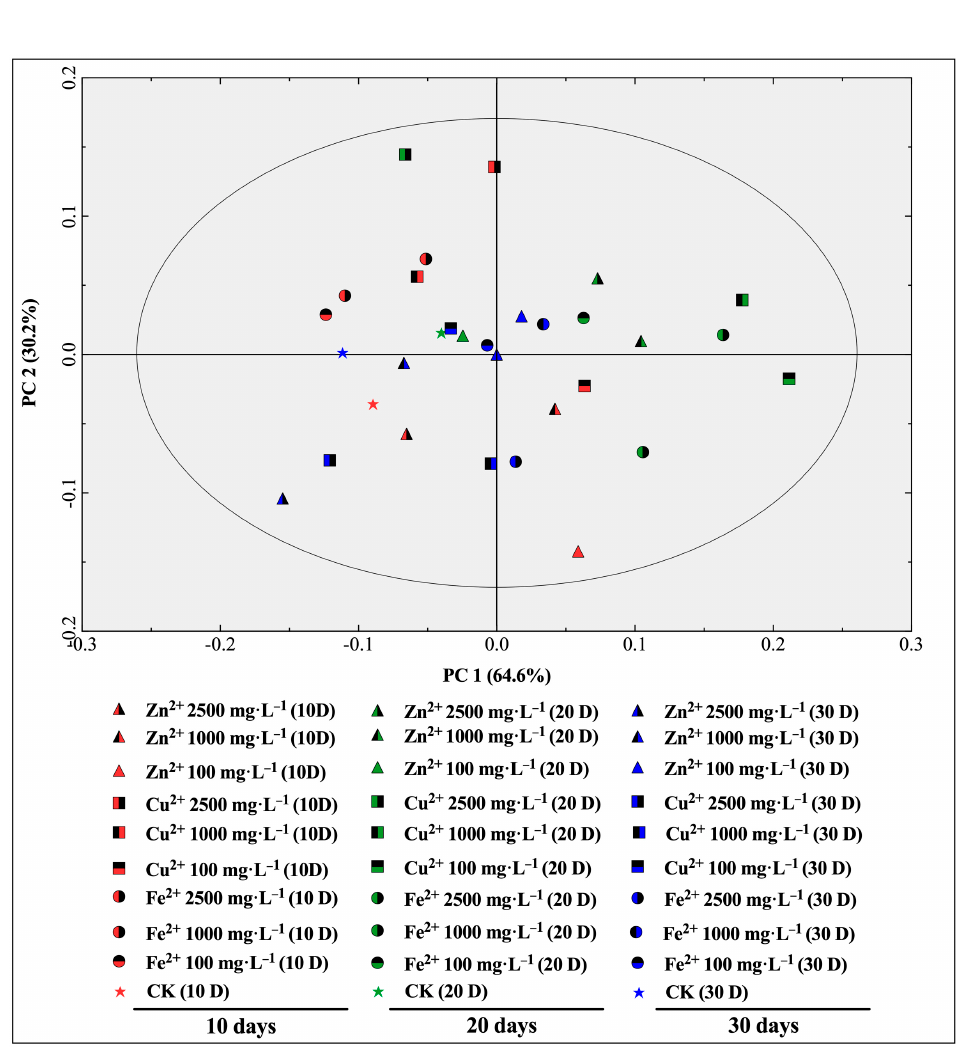
Figure 5. Coefficients plot ( A ) and VIP plot ( B ) of the characteristic absorption peaks in E. sagittatum leaves subjected to FT-IR under the OPLS-DA model. 3.4. Widely Untargeted Metabolomic Analysis of E. sagittatum Leaves According to the HPLC analysis in this study, high-concentration Fe 2+ (2500 mg·L − 1 ) had a more positive effect on flavonoids in E. sagittatum leaves. Therefore, the widely un- targeted metabolomic analysis carried out by UPLC-MS/MS aimed at deciphering the ef- fects of Fe 2+ on the metabolites in E. sagittatum leaves. Basic metabolite information of Fe 2+ (2500 mg·L − 1 ) and CK ( n = 6) based on widely untargeted metabolomics is shown in Figure 6. The average retention time and m/z of positive and negative ions are shown in Figure 6A. The m/z of the positive ions is concentrated between 200 and 650. The m/z of the neg- ative ions is concentrated between 400 and 800. We have demonstrated the overall differ- ences in metabolites between Fe 2+ and CK using the partial least squares discriminant analysis (PLS-DA) (Figure 6B), which effectively reveals the differences between the two groups of metabolites. Figure 6C–E show the significance analysis of DAMs between Fe 2+ and CK. The Volcano plot also presents the most distinct DAMs between Fe 2+ and CK. A total of 32,835 metabolites were detected in this study, of which 1243 metabolites showed significant differences (presented by Figure 6D), including 791 positive ions (199 signifi- cantly up-regulated DAMs and 592 significantly down-regulated DAMs) and 452 nega- tive ions (99 significantly up-regulated DAMs and 353 significantly down-regulated DAMs). The next step of the analysis focused on the classes to which these DAMs be- longed, and the patterns of change after high-concentration Fe 2+ treatment.